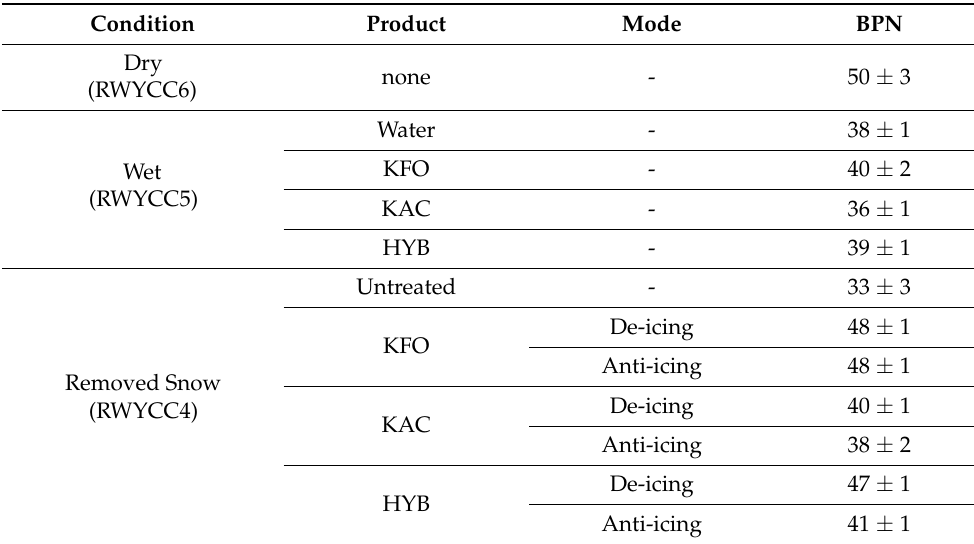
Table 2. BPN results obtained in the RWYCC